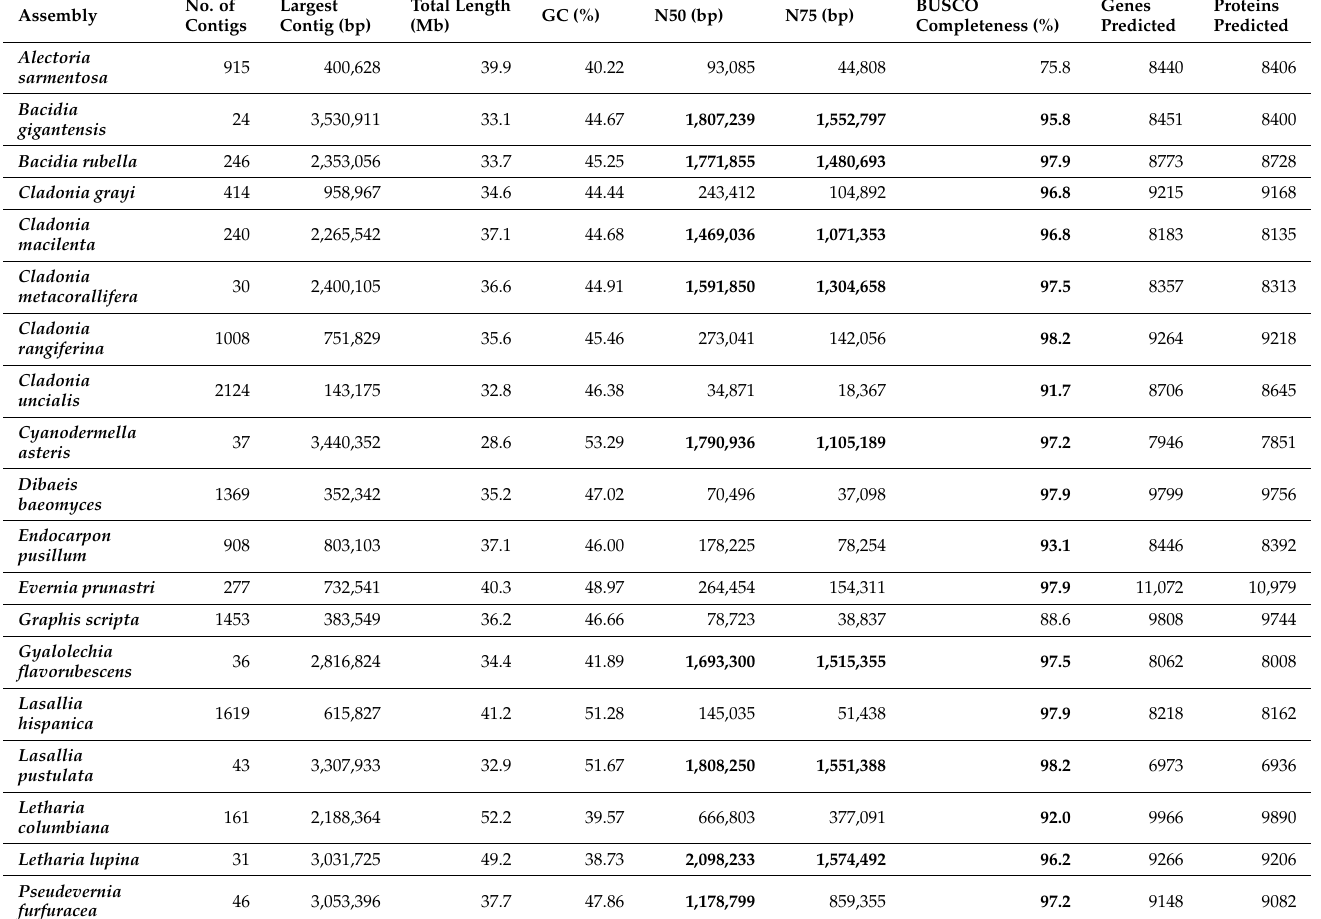
Table 4. Genome basics for twenty-three studied fungal